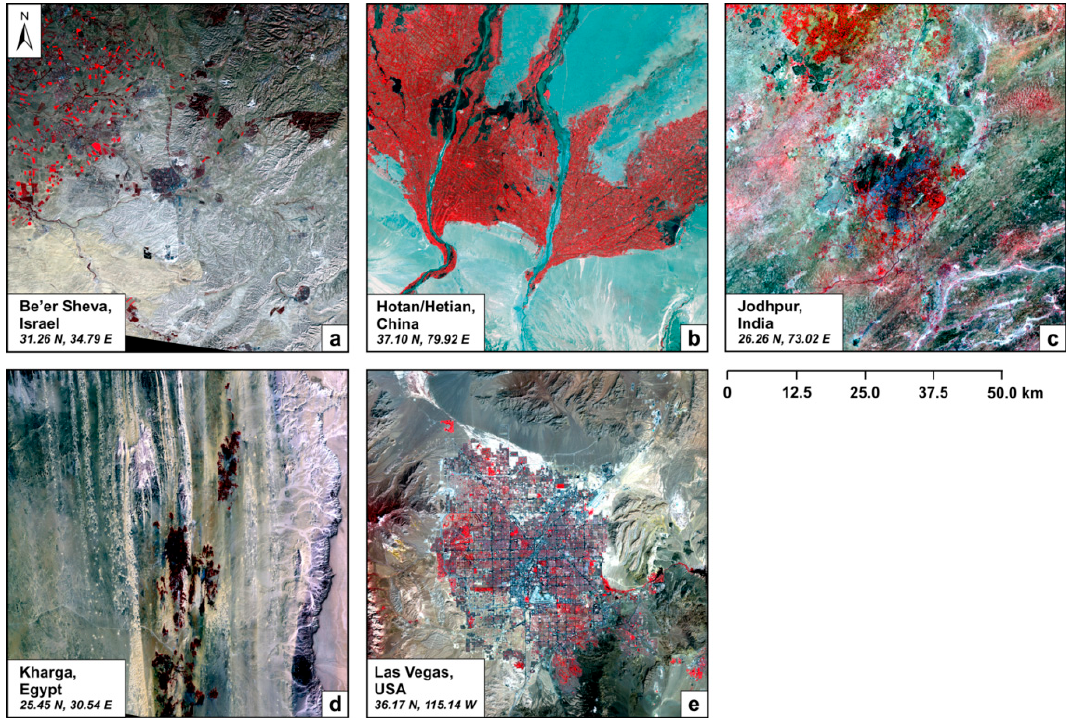
Figure 2. Landsat images for the five desert cities displayed in false color composite: ( a ) Beer Sheva, Israel. Image acquired on 3 December 2010; ( b ) Hotan, China. Image acquired on 22 June 2010; ( c ) Jodhpur, India. Image acquired on 28 September 2009; ( d ) Kharga, Egypt. Image acquired on 12 March 2010; ( e ) Las Vegas, NV, USA. Image acquired on 2 November 2011.